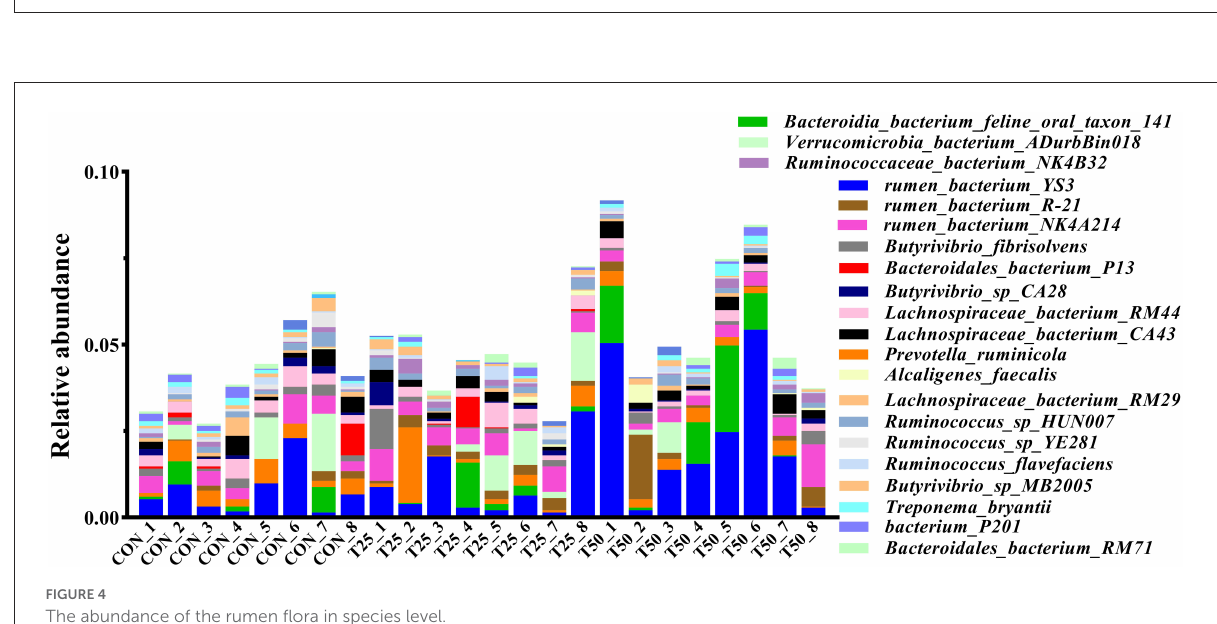
FIGURE4 The abundance of the rumen flora in species